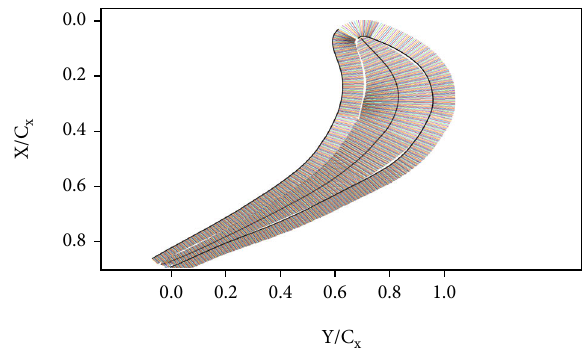
Figure 10: Locations of polynomial equations and regions for line averaging, along the squealer blade tip surface, for the pressure side rim, the squealer recess region, and the suction side rim.